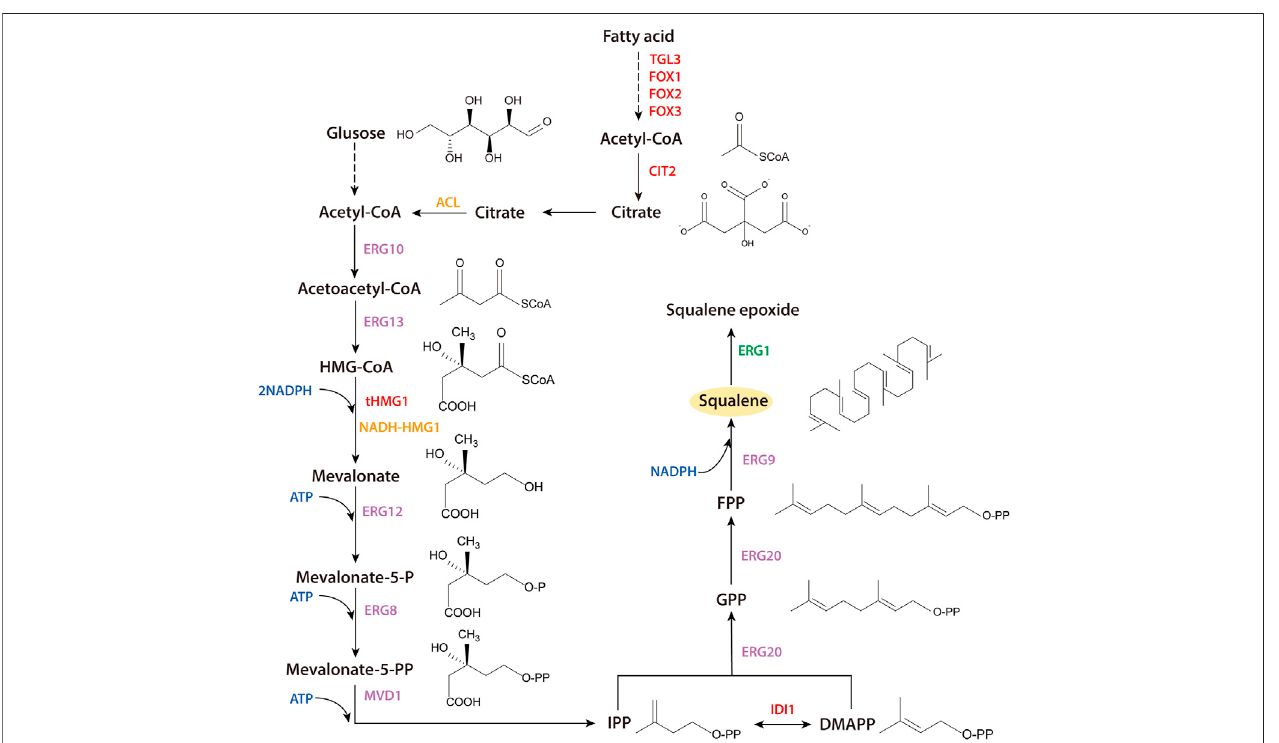
FIGURE 1 | Engineered metabolic pathway of squalene production in S. cerevisiae . Heterologous expressed genes are highlighted in orange. Over-expressed genes are highlighted in red; downregulated genes are highlighted in green. HMG-CoA, 3-hydroxyl-3-methyl-glutaryl-CoA; IPP, isopentenyl diphosphate; DMAPP, dimethylallyl diphosphate; GPP, geranyl diphosphate; FPP, farnesyl diphosphate.